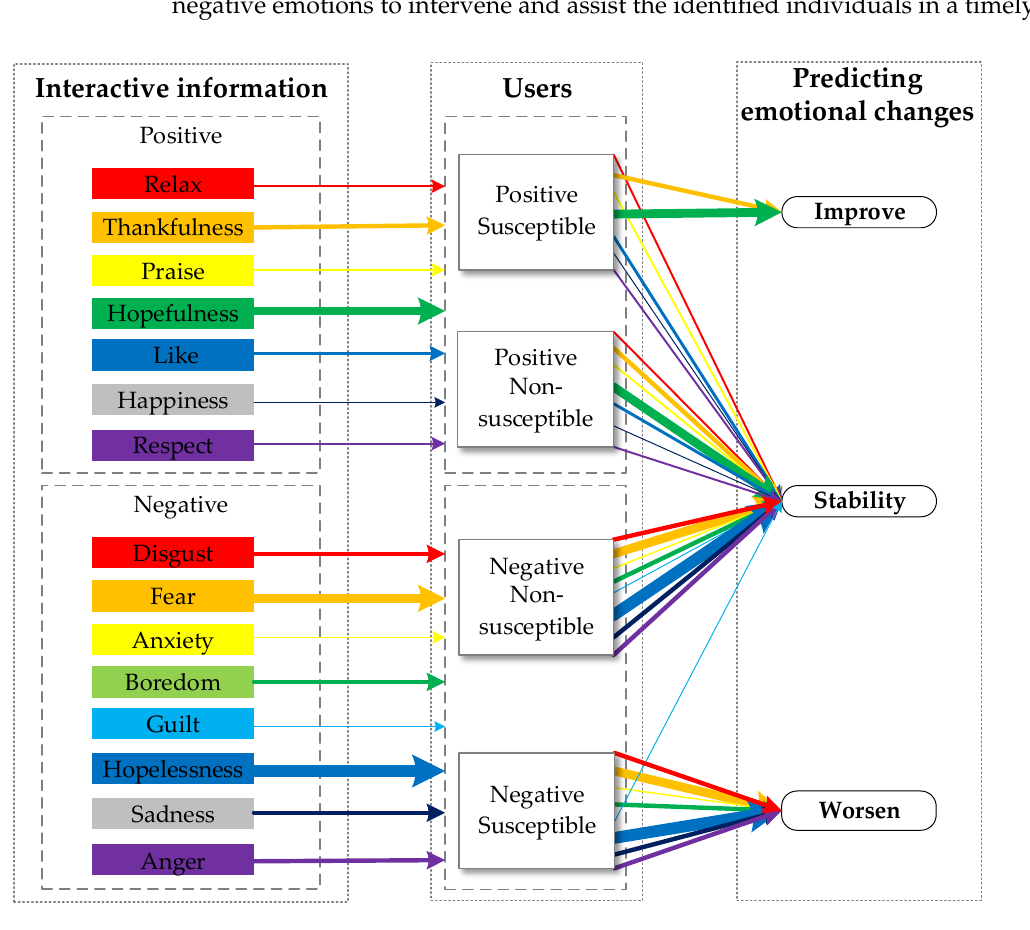
Figure 6. Model of users’ online behavior. Note: The thickness of the line represents the degree of influence of different emotional themes.